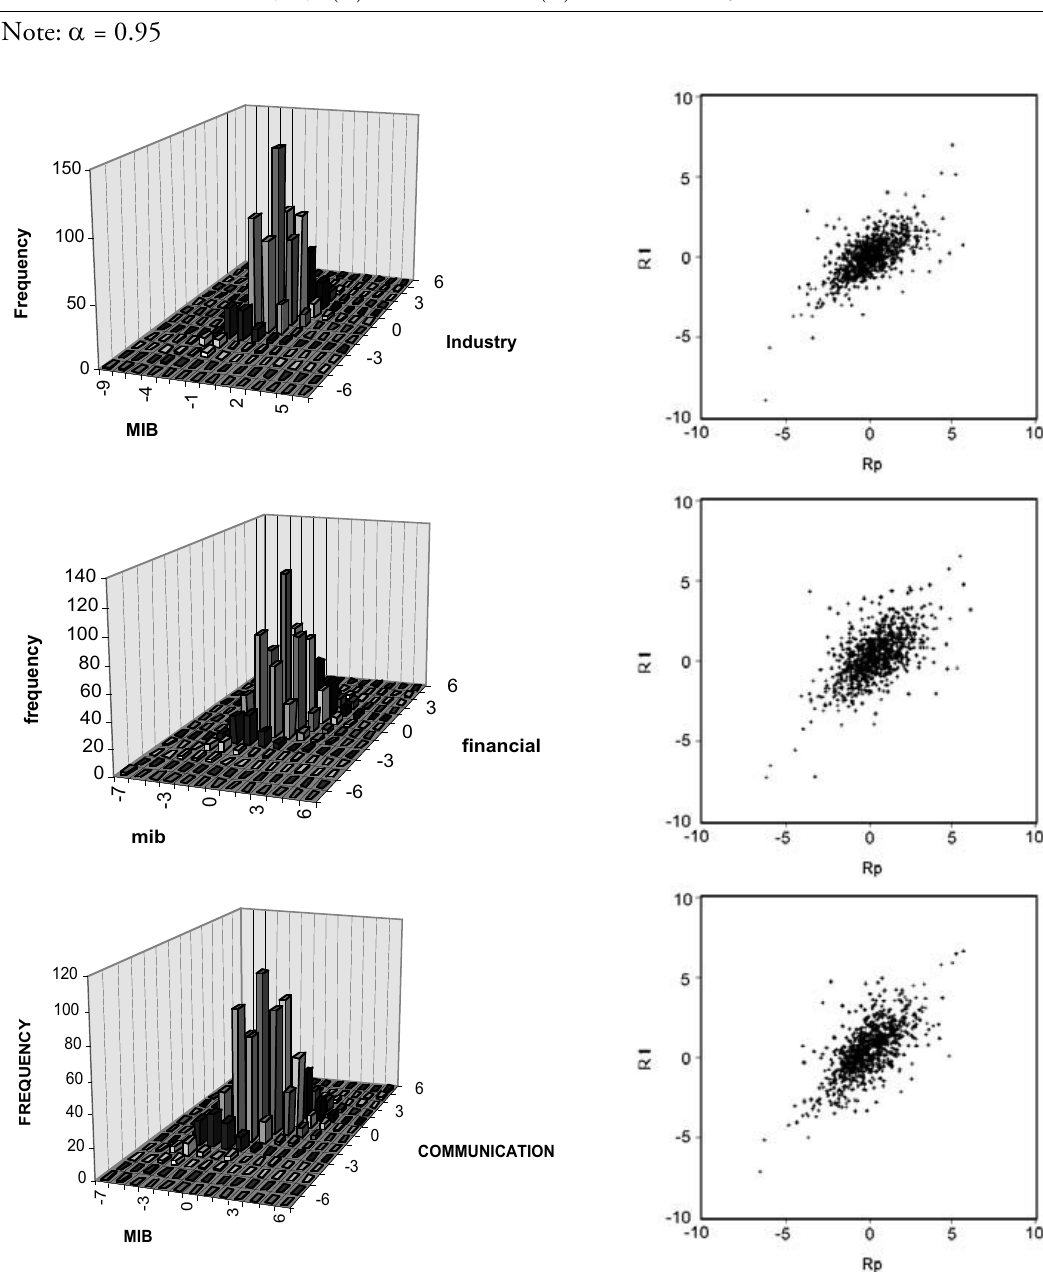
Figure 4 – Joint distributions of each sectors’ returns and MIB returns (14th October 1994 - 18th August 1998).